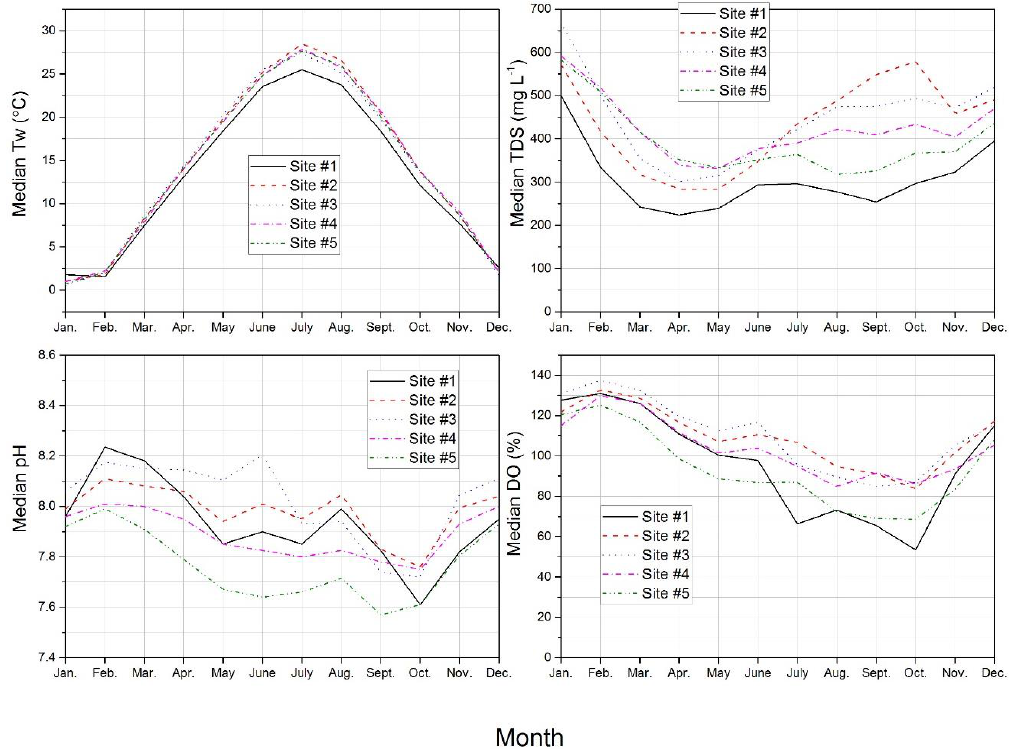
Figure 8. Median monthly water temperature (Tw) (°C), total dissolved solids (TDS) (mg L −1 ), pH,